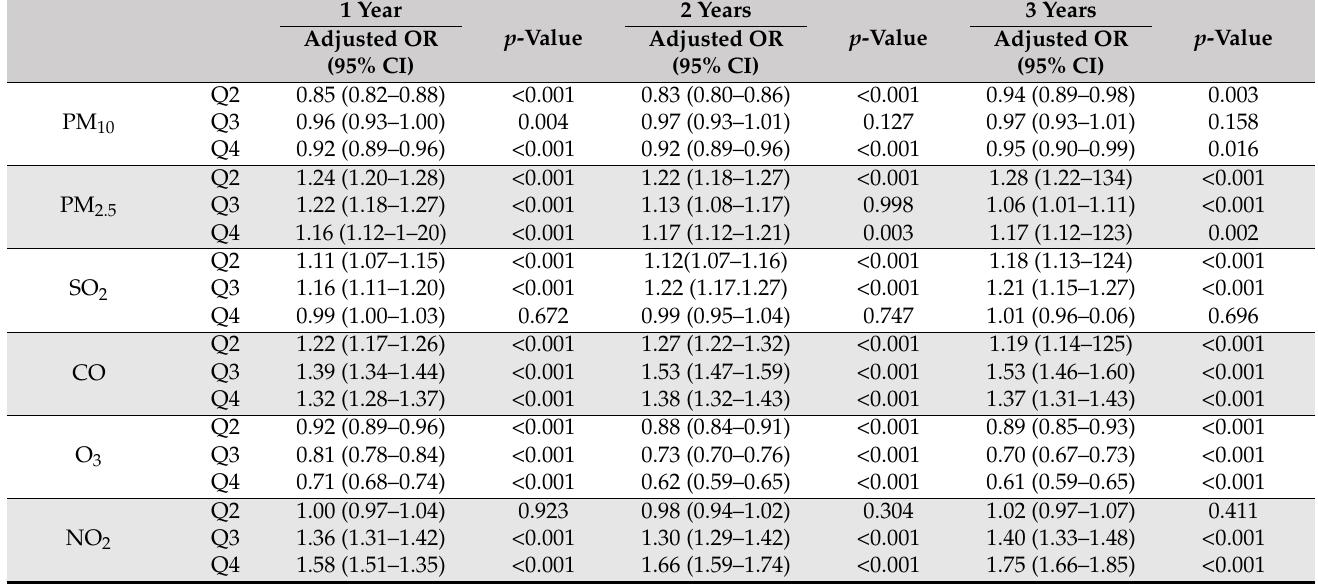
Table 4. Association between exposure concentration and risk for polycystic ovarian